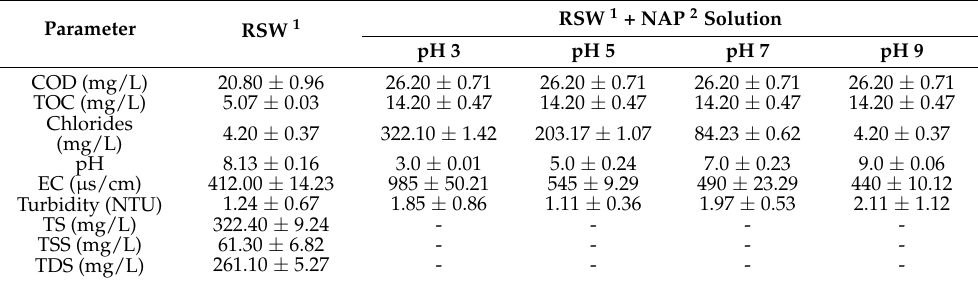
Table 1. Characterization of raw surface water and naproxen